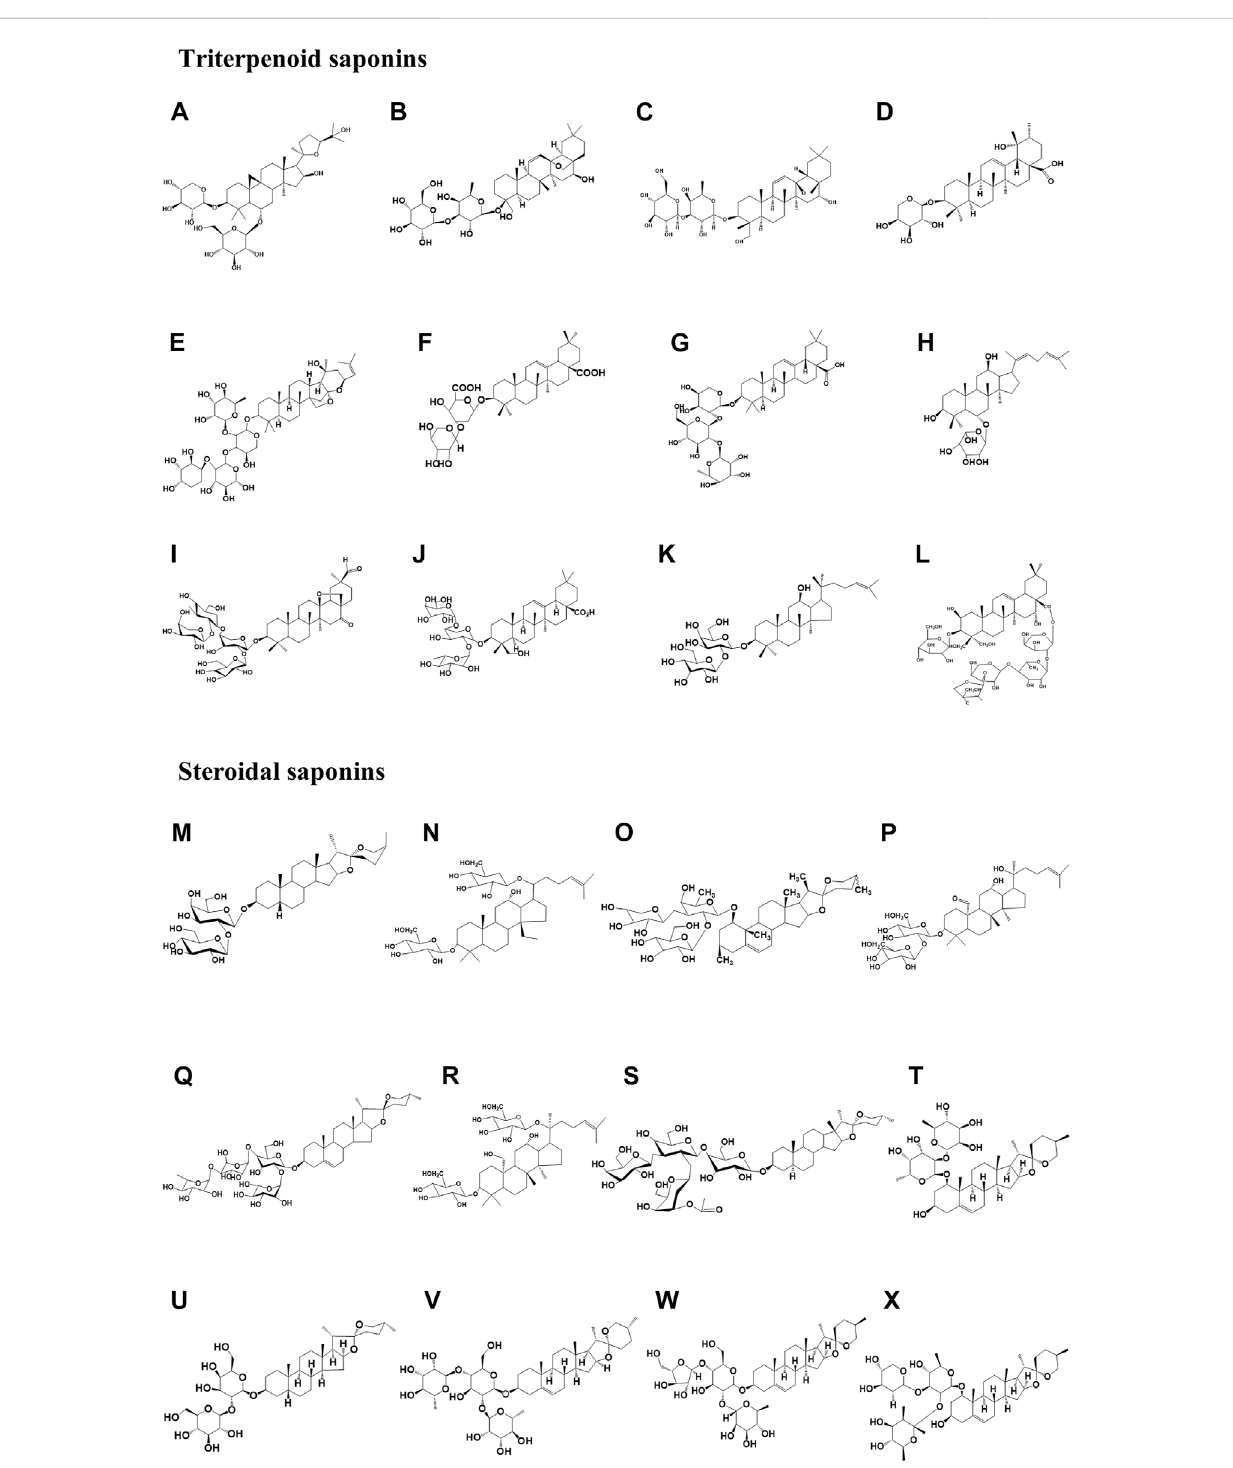
FIGURE 2 Chemical structure of triterpene saponins and steroidal saponins involved in the paper. Among them, (A) Astragaloside IV (Molecular formula: C 41 H 68 O 14 ), (B) Saikosaponin-A (Molecular formula: C 41 H 66 O 13 ), and (C) TSBE (Molecular formula: C 42 H 69 O 13 ), (D) Ziyuglycoside II (Molecular formula: C